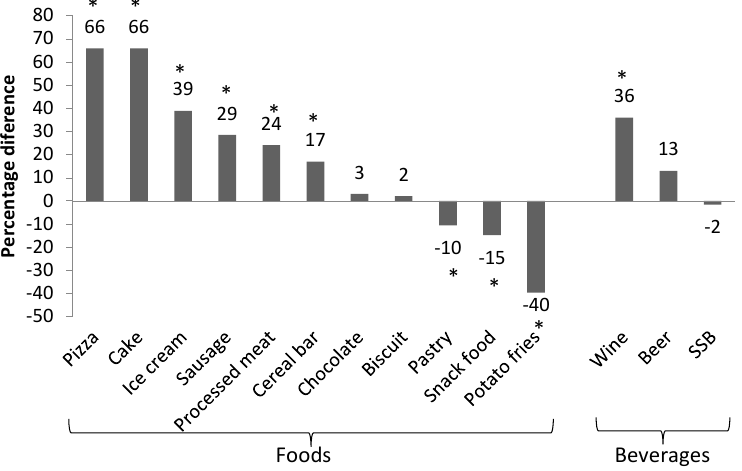
Figure 1. Percentage difference in median portion size (kJ) between 1995 and 2011–2012 by food category. * p <